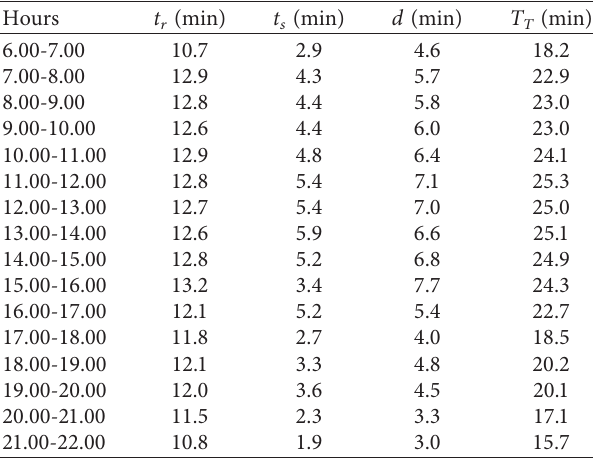
Table 7: Travel time in direction A, obtained in the model. Table 8: Travel time in direction B, obtained in the